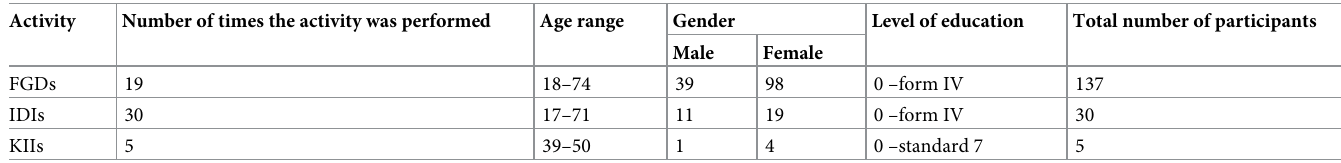
Table 1. Information for FGDs, IDIs, & KIIs